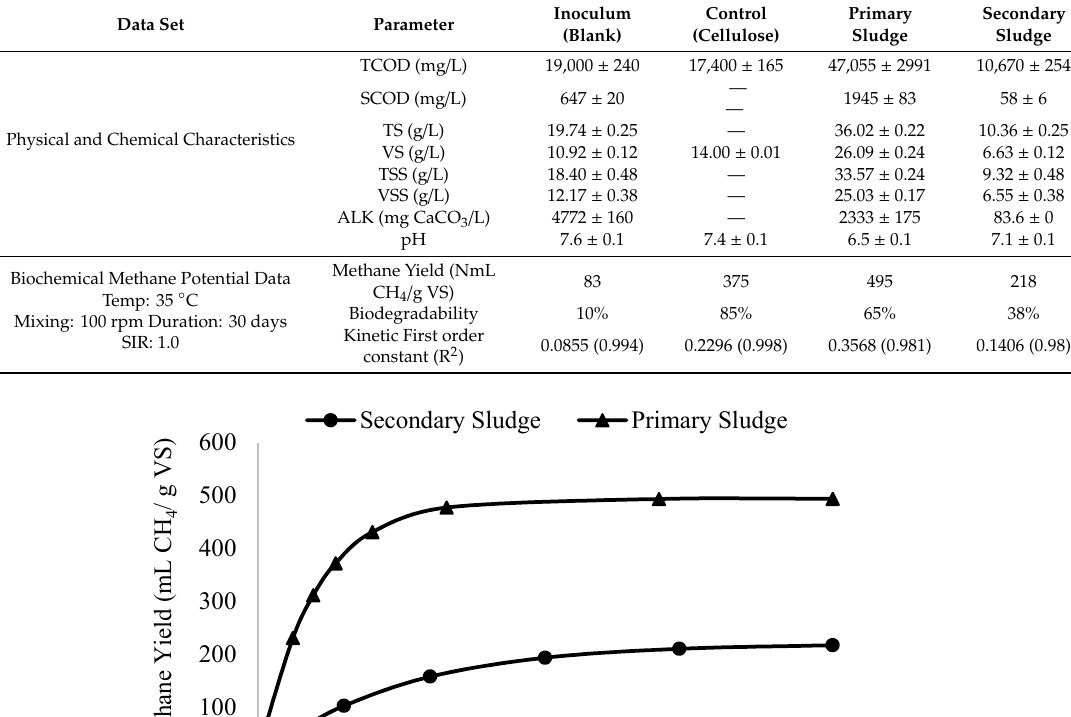
Table 8. Example final data information for primary and secondary WWTP sludge.